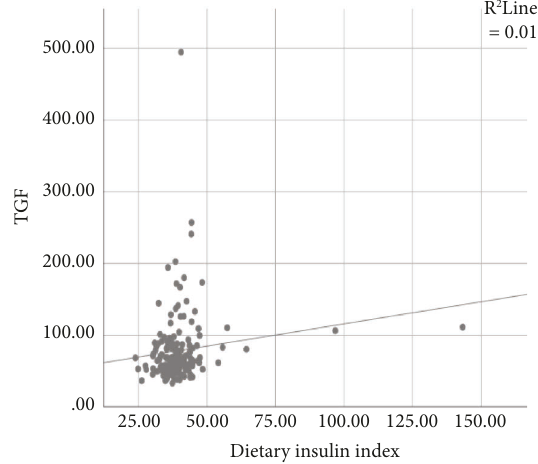
Figure 1: Nonsignificant Pearson correlation between TGF- α and dietary insulin index; p value: 0.06; r: